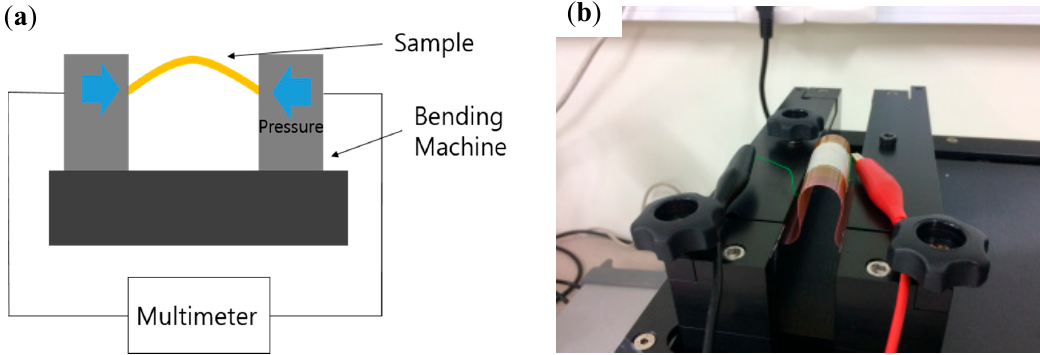
Figure 1. Output voltage measurement system used in this work: ( a ) schematic diagram and ( b ) real sample bending/unbending stage.